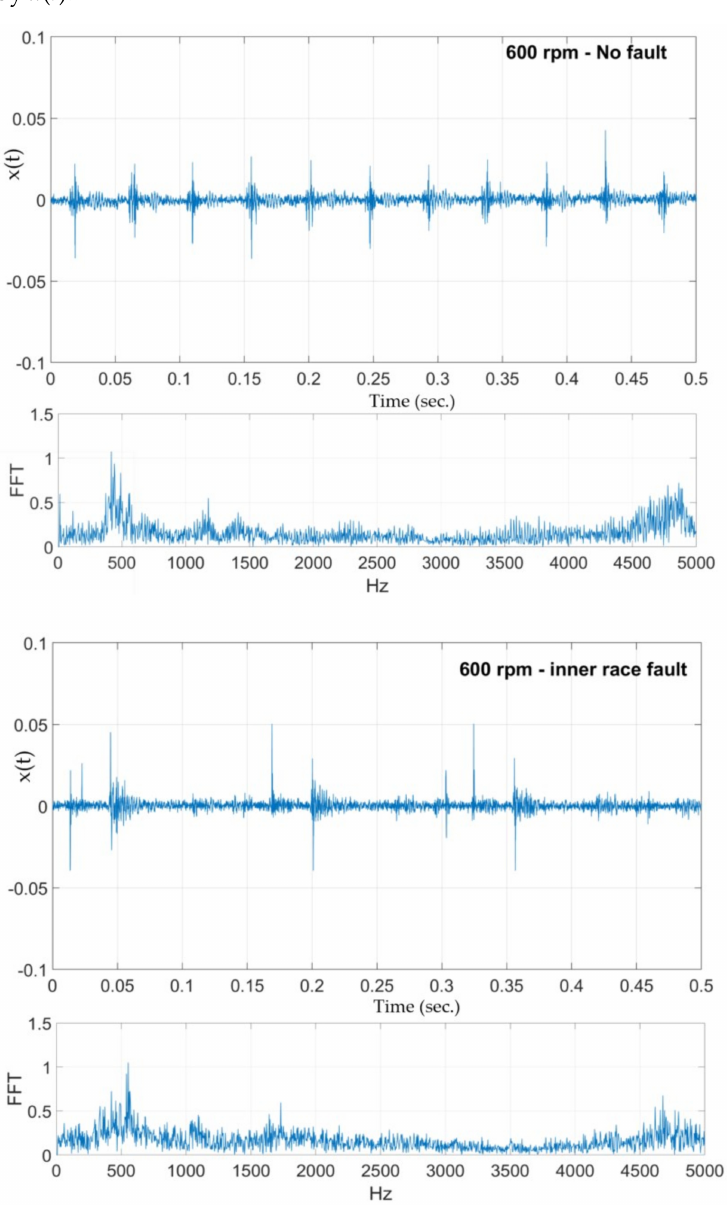
Figure 13. Vibration time signatures and corresponding FFT spectrum for two cases. All feature attributes are scaled and normalized across the column before